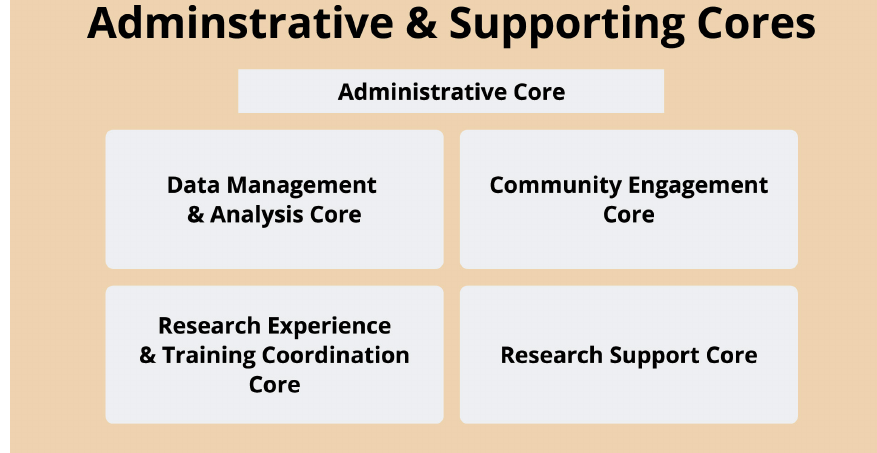
Figure 2 : An illustration of the four research cores in the project. Note that the Research Core contains four separate research